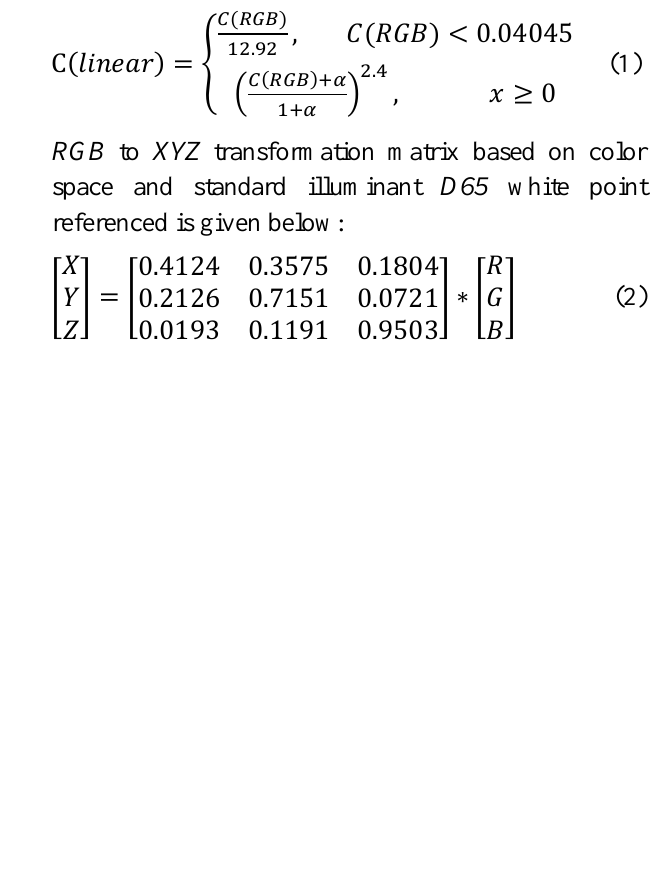
Fig. 2. Sample Images of Potato leaves. (a) Healthy leaves samples (b) Early blight samples (c) Late blight